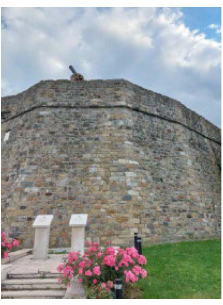
Figure 18. The walls were repaired only from the outside (Photo source: Branko Slavkovi´c).